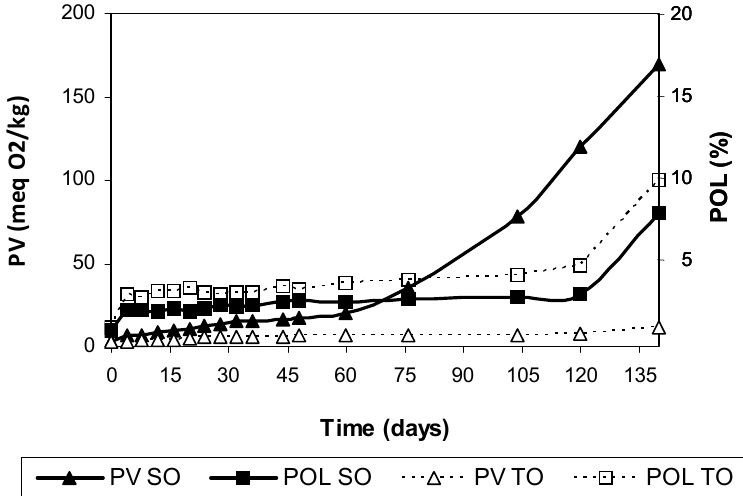
Figure 2. Peroxide values and polymer concentrations during storage of safflower oil (SO) and Tonalin oil (TO) at 25 °C in the dark. Data are expressed as Means ( n = 3 experiments). Coefficients of variation were equal to or lower than 8% for peroxide values and 5%